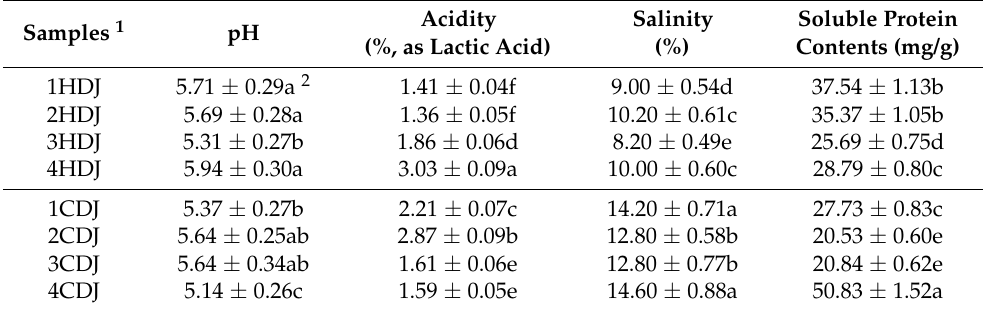
Table 1. Comparisons of physicochemical properties of household and commercial doenjang . Samples 1